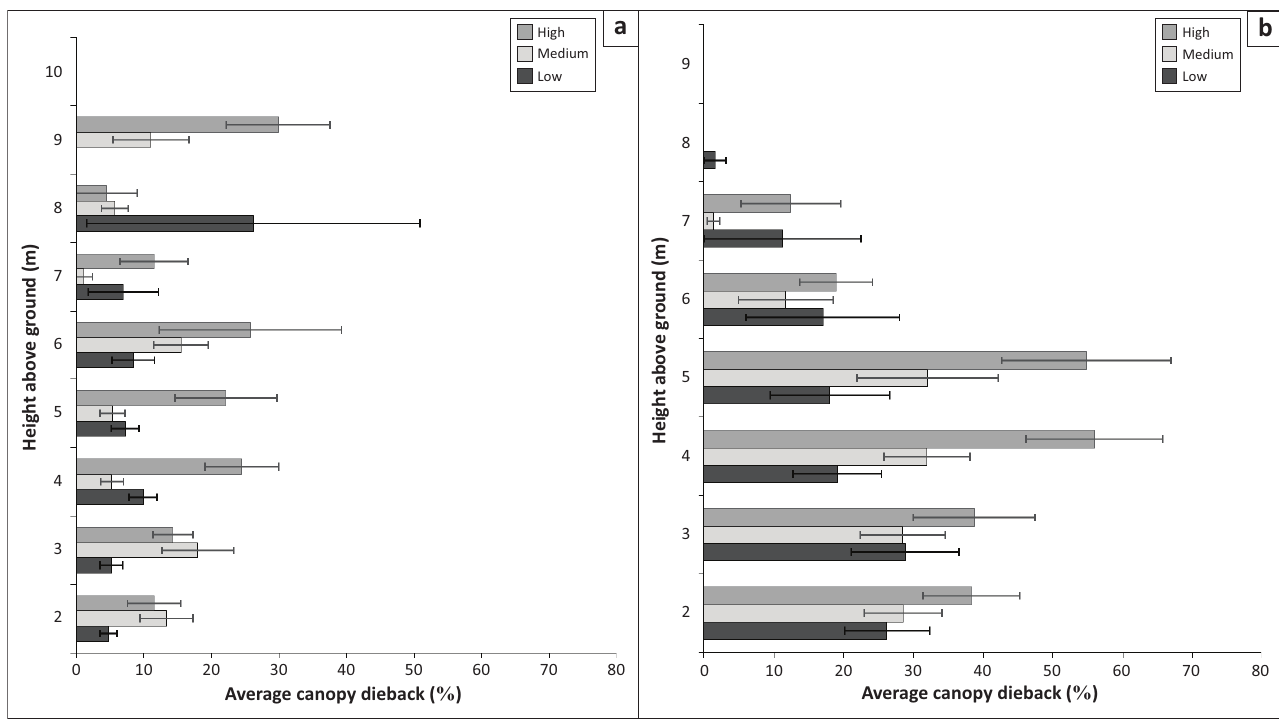
FIGURE 2: Average canopy dieback for (a) Vachellia erioloba and (b) Vachellia haematoxylon in each of the giraffe density